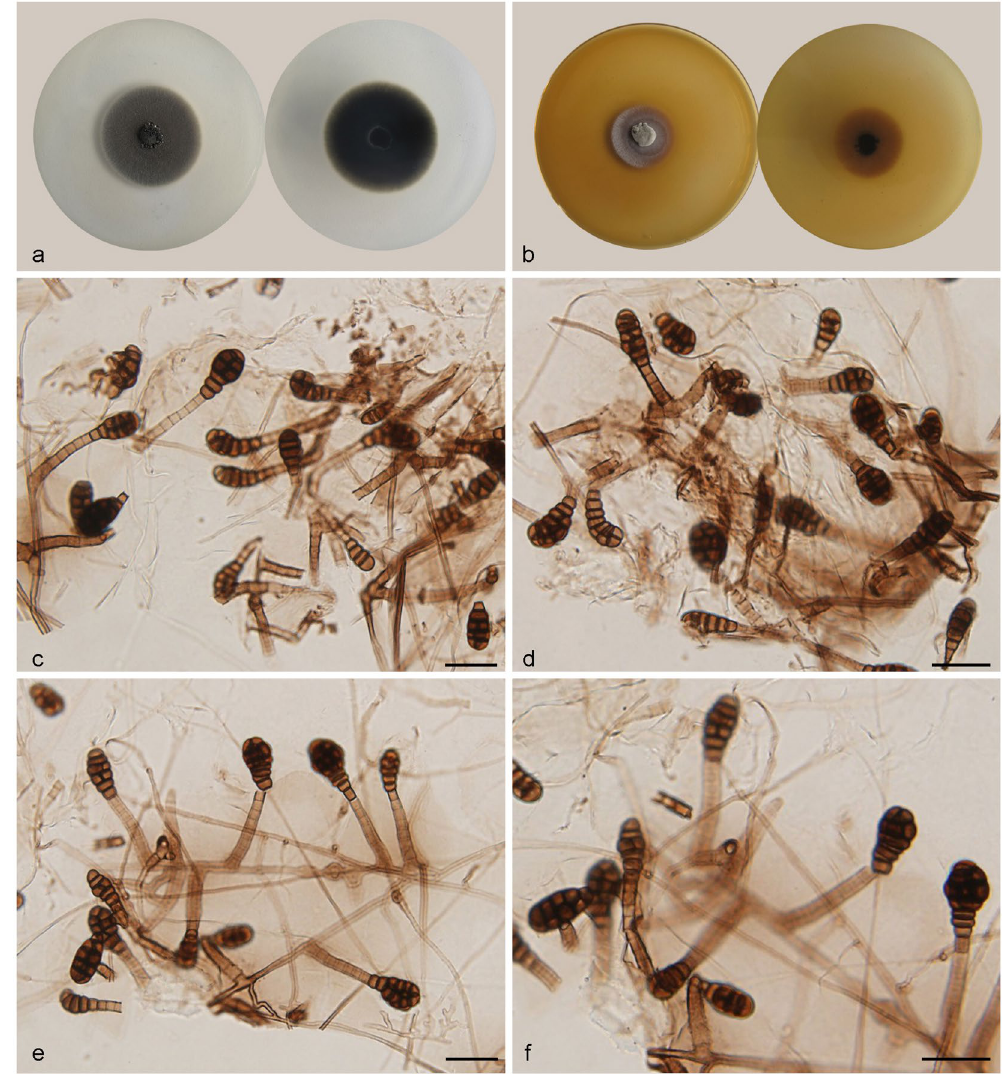
Figure 5. Acrodictys hainanensis. ( a ) Colony on PDA (surface and reverse). ( b ) Colony on MEA (surface and reverse). ( c – f ) From PDA (CGMCC 3.18645): Conidiophores and conidia. — Scale bars = 20 μ